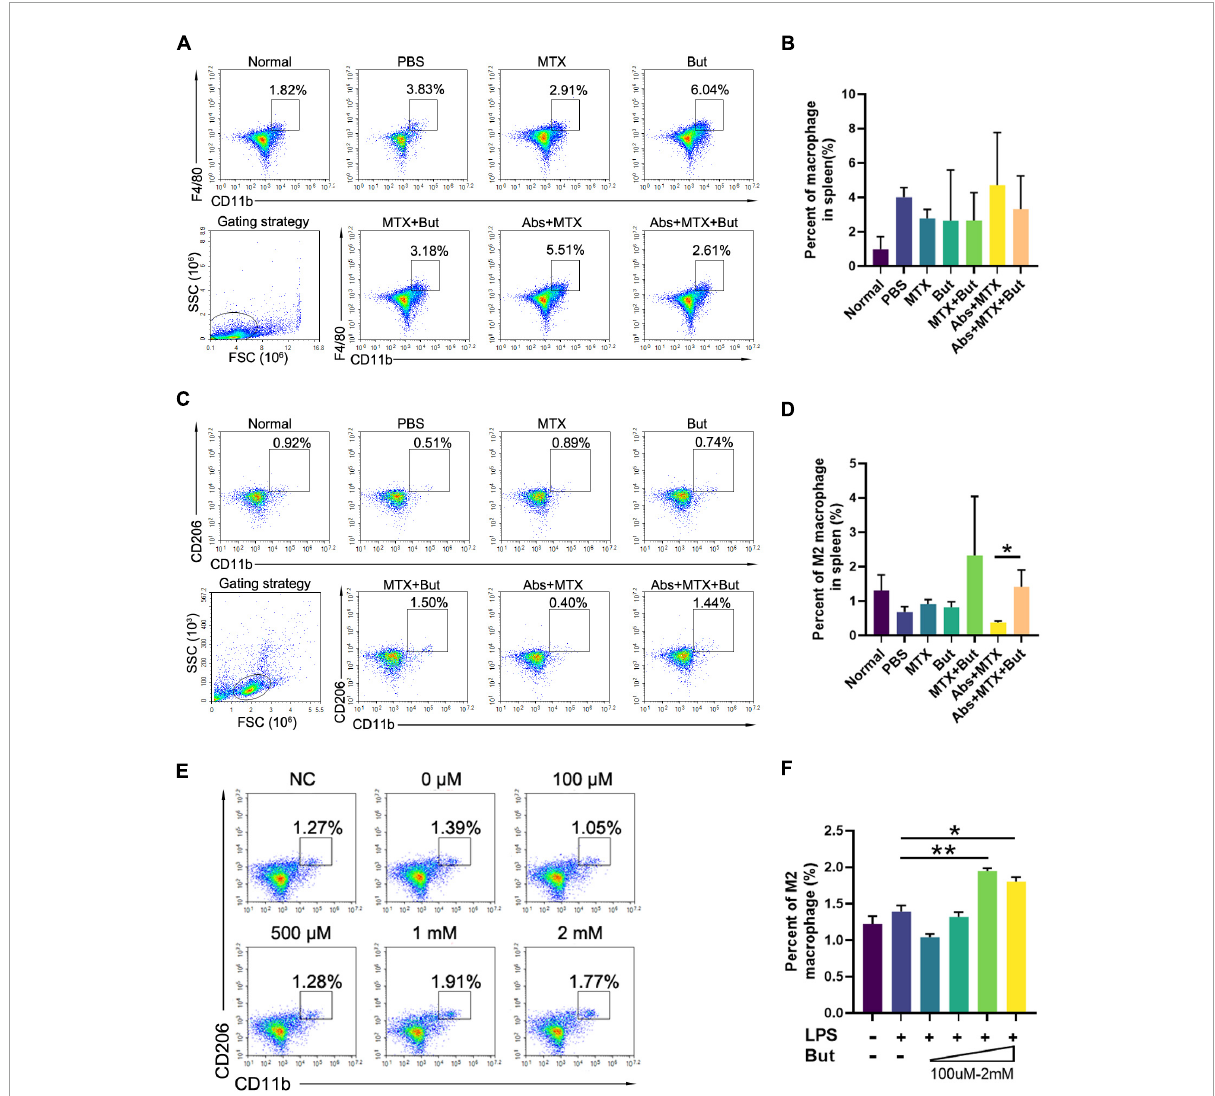
FIGURE6 The impact of butyrate on macrophage. (A–D) FACS analysis of splenic cells. (A,B) Macrophages and C,D M2 macrophages ( n = 3). (E,F) FACS analysis of macrophage in vitro . Cells isolated from the spleen were stimulated with lipopolysaccharide (LPS, 100 ng/ml) with or without butyrate (But, 100 µ M–2 mM) for 24 h before FACS analysis. The alteration of (E,F) M2 macrophages ( n = 3) were recorded. Data are presented as the mean ± SEM. * p < 0.05, ** p < 0.01. Abs, antibiotics; But,